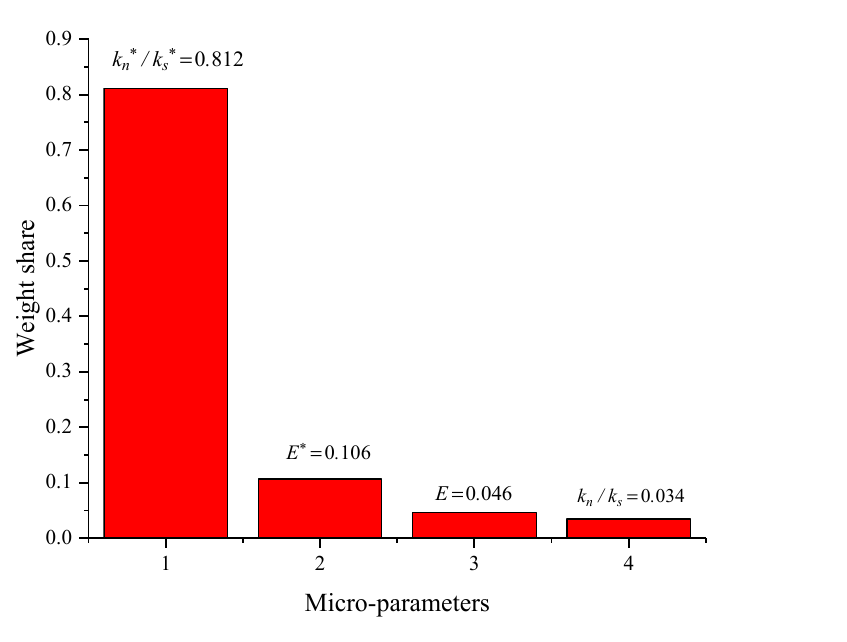
* * k / k is the highest, reaching n s k / k are the low- n s